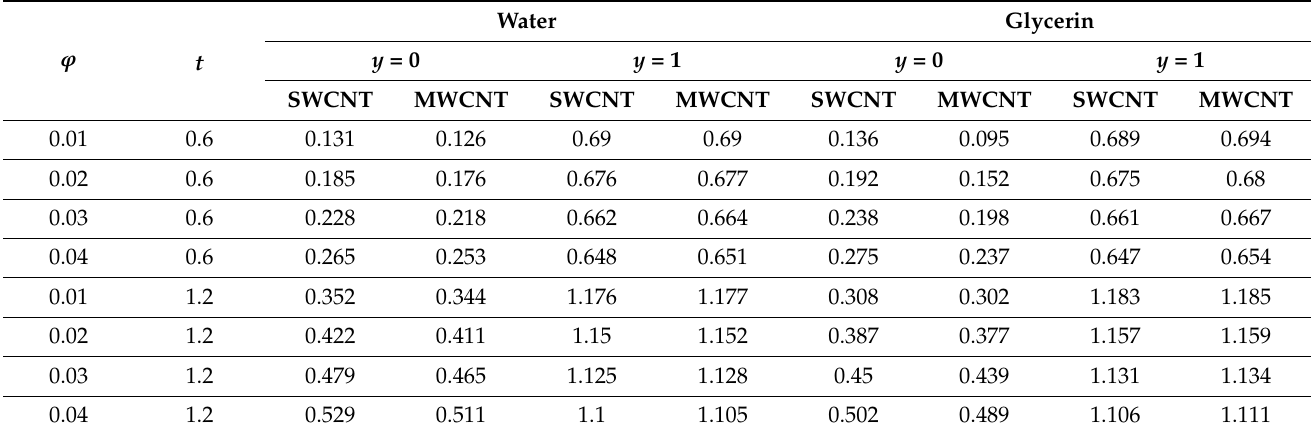
Table 4. Deviation of Sherwood numbers for various values of ϕ